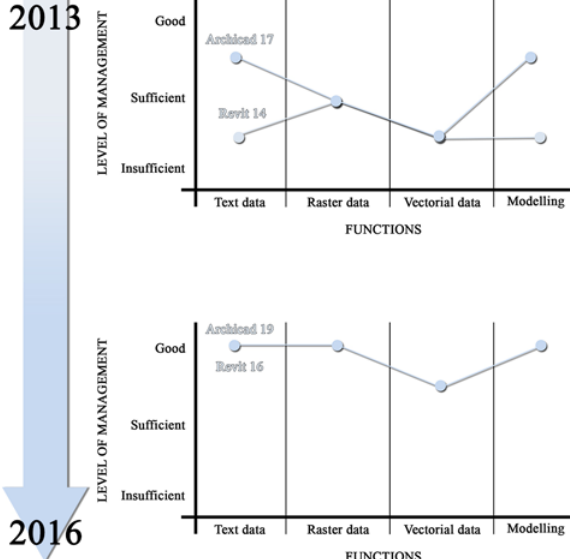
Figure 2. Evolution of the competencies and performances in data managing of two BIM software: Graphisoft Archicad and Autodesk Revit.